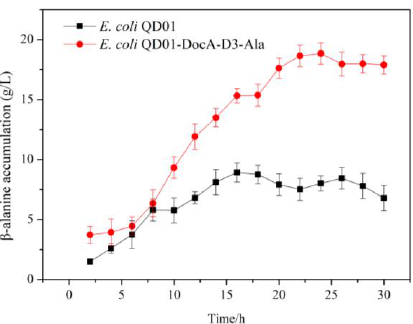
Figure 7. Assembly efficiency of cellulosome elements combined with key enzymes in β -alanine fermentation. Changes in β -alanine accumulation during bacterial fermentation.